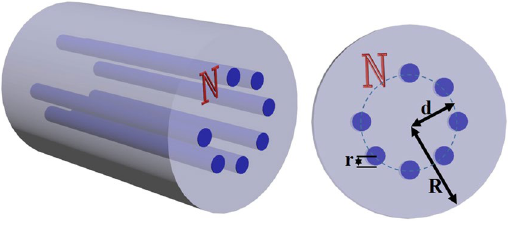
Figure 1. Structure of NCSF. Three dimensional structure and cross-section of an NCSF for OAM conversion and